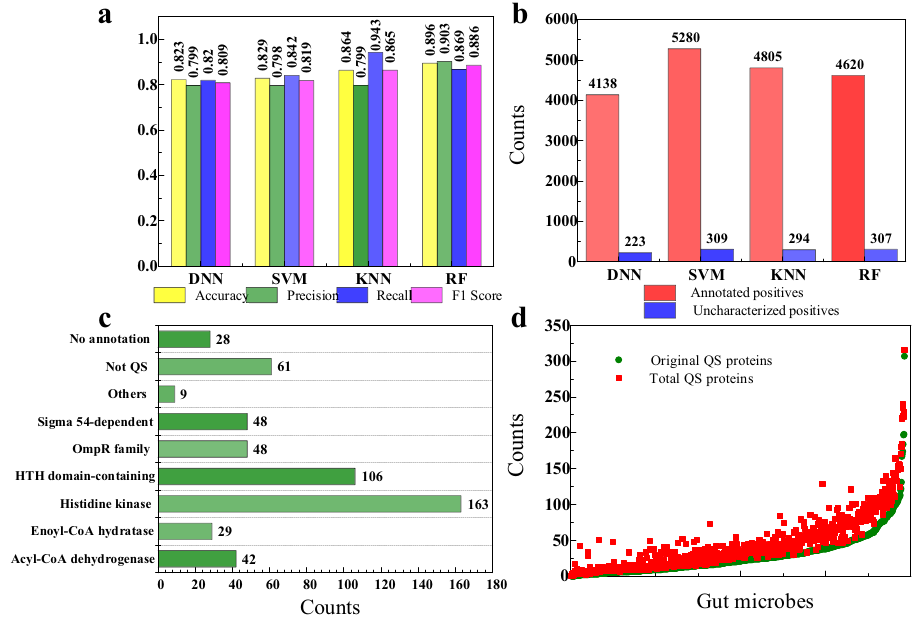
Fig. 3 Results of the expansion and mining for QS entries based on the proposed systematic work fl ow. a Accuracy, precision, recall, and F 1 score of the four classi fi ers based on DNN, SVM, KNN, and RF algorithms. b Counts of the annotated and uncharacterized positives for the union set of positives from DNN, SVM, KNN, and RF classi fi ers; c Results of the protein clusters of 534 re-annotated protein entries. d Distribution total of 28,567 redundancy removal entries in 818 gut microbes. Source data are provided as a Source Data fi le.